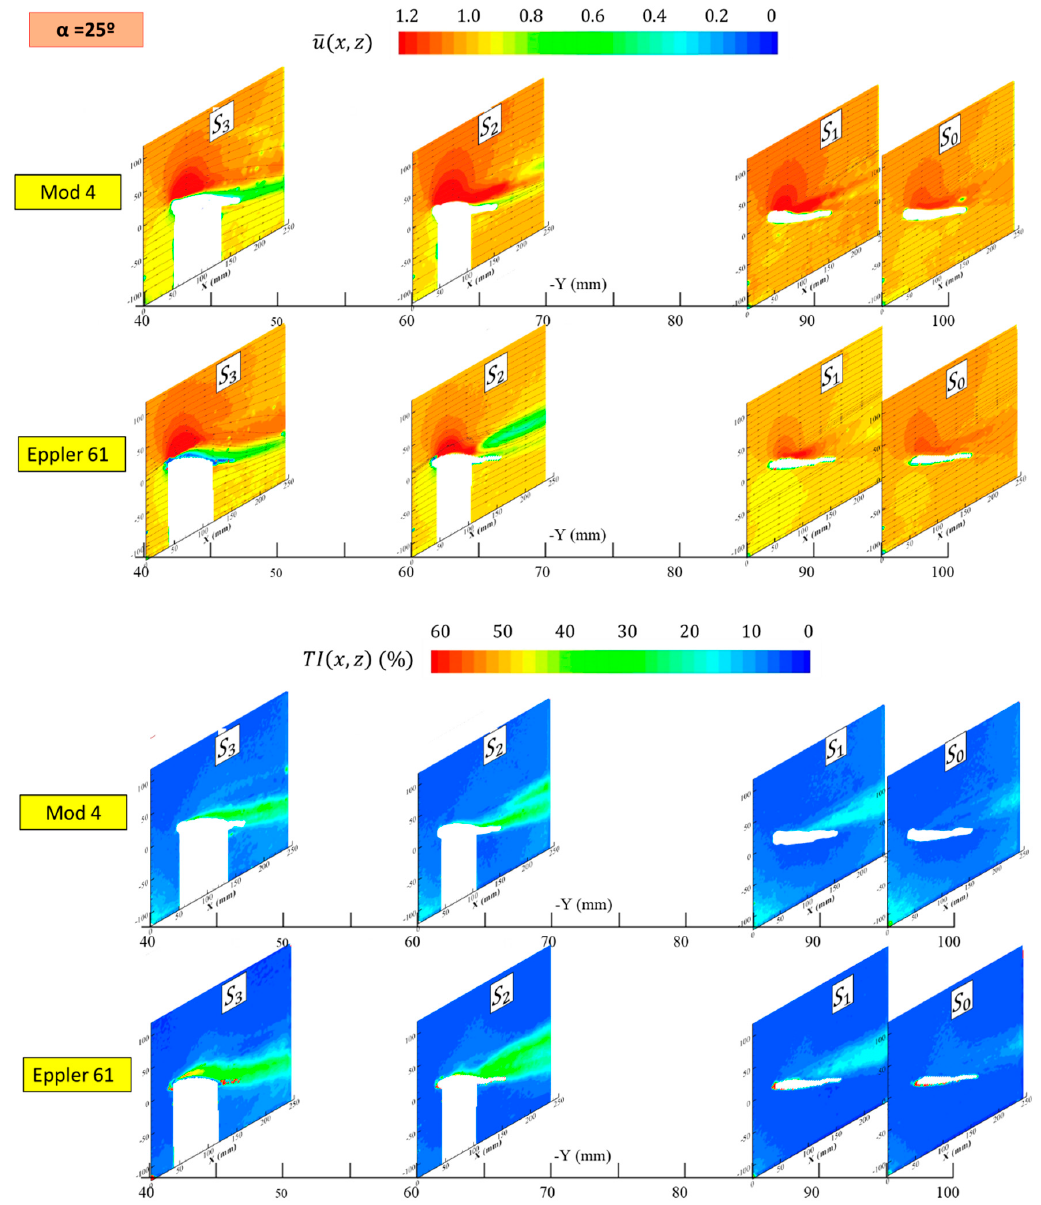
Figure 10. Non-dimensional velocity maps and turbulence intensity maps for each section at an angle of attack of 25°.